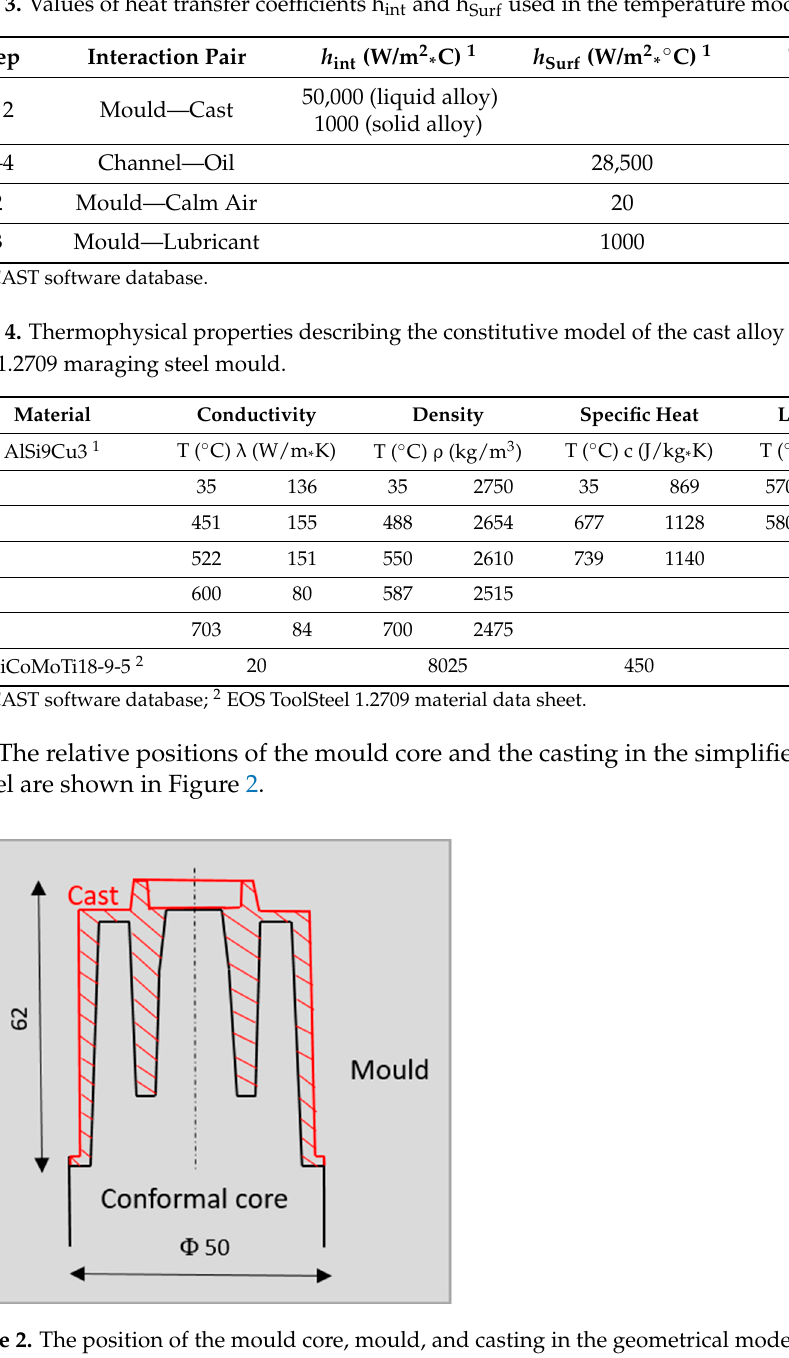
Table 3. Values of heat transfer coefficients h int and h Surf used in the temperature model.